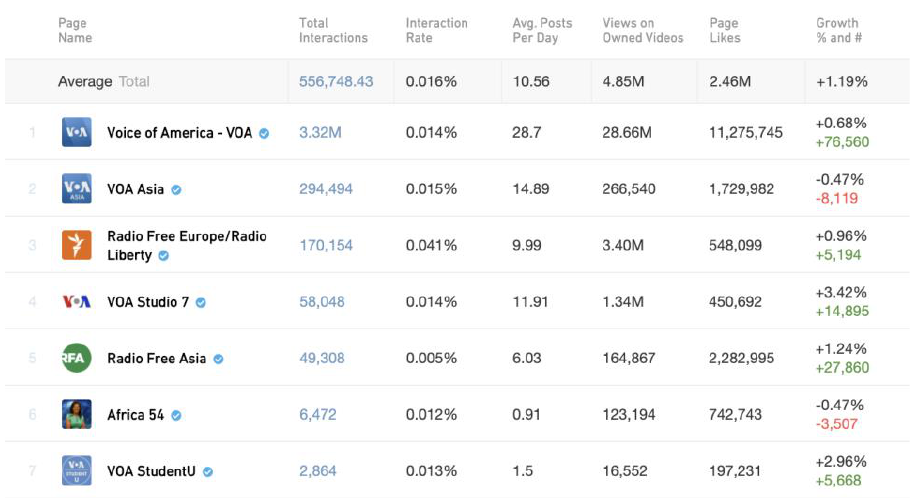
Table C : List of U.S. government-funded media Facebook pages analyzed using the tool CrowdTangle from Jan 1, 2019 to March 31, 2020, showing a smaller audience size, much slower audience growth, and significantly higher audience interaction rates as compared to the outlets in Table